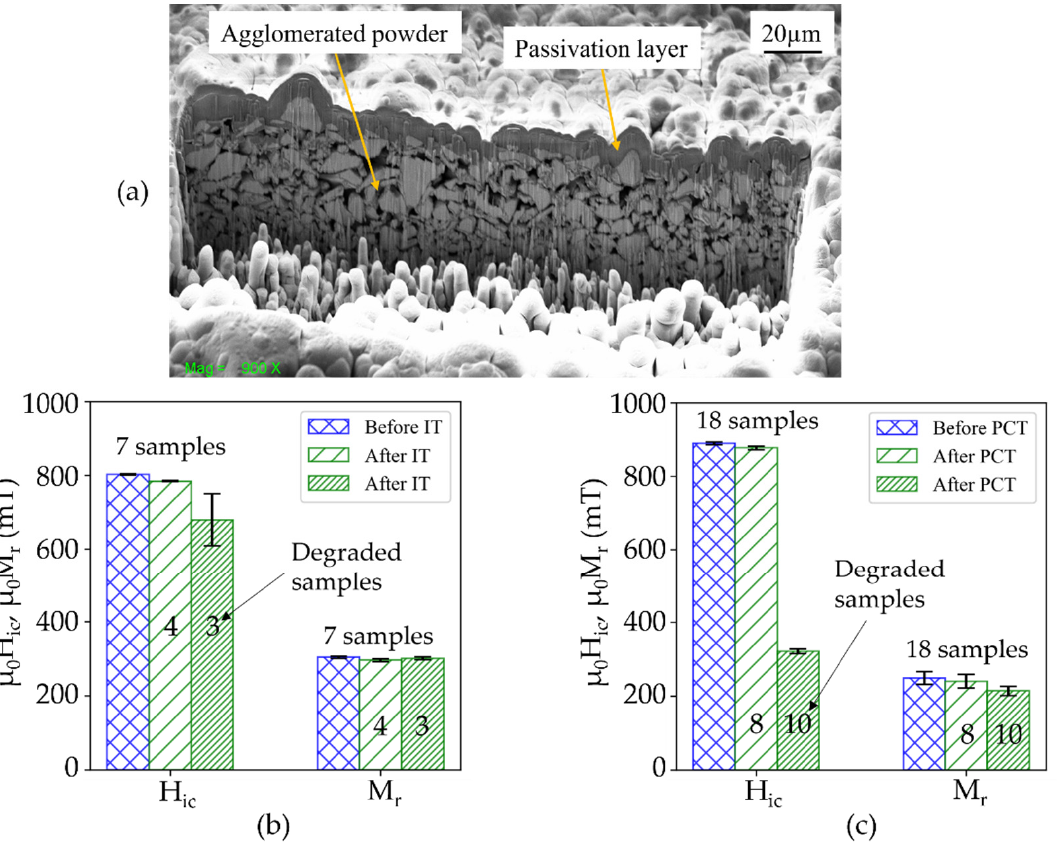
Figure 14. ( a ) FIB-cross section of a passivation layer of 3 µm silicon oxide deposited by PECVD at 400 °C on top of a powder-based NdFeB micromagnet. Magnetic properties of passivated NdFeB micromagnet before and after ( b ) immersion test and ( c ) pressure cooker test. Numbering on top of the error bars indicate measured samples.